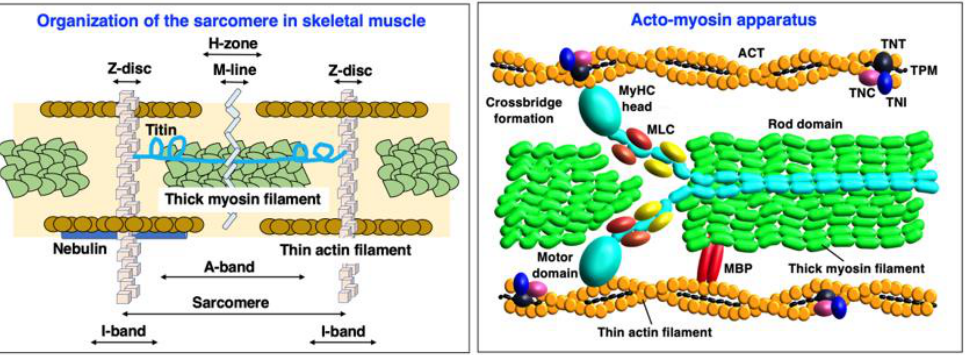
Figure 1. Overview of the sarcomeric structure and the contractile acto-myosin apparatus of skeletal muscle. The diagram to the left outlines the arrangements of the thick myosin-containing filament, the half-sarcomere spanning titin filament and the actin/nebulin-containing thin filament in relation to their positions within the A-band, the I-band, the H-zone, the M-line and the Z-disc structures of the sarcomere. The diagram to the right shows the interactions between the head structure of myosins and filamentous actin molecules that are involved in the crossbridge formation during skeletal muscle contractions. Details of the subunit composition and isoform diversity of myosin heavy chains, myosin light chains, myosin binding proteins, actins, tropomyosins and troponins are given in Figure 2 below. Abbreviations used: ACT, actin; MLC, myosin light chain; MYBP, myosin binding protein; MyHC, myosin heavy chain; TNC; troponin-C; TNI; troponin-I; TNT, troponin-T; TPM, tropomyosin.